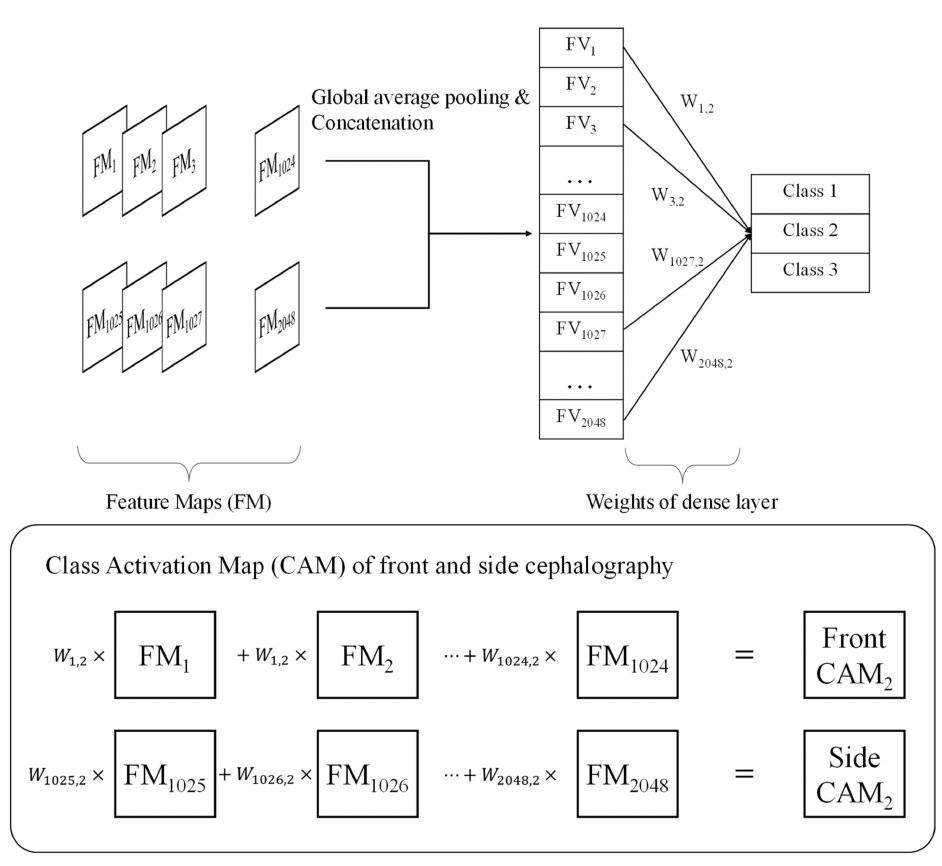
Figure 5. Class activation map (CAM) generation of PA and lateral cephalometric